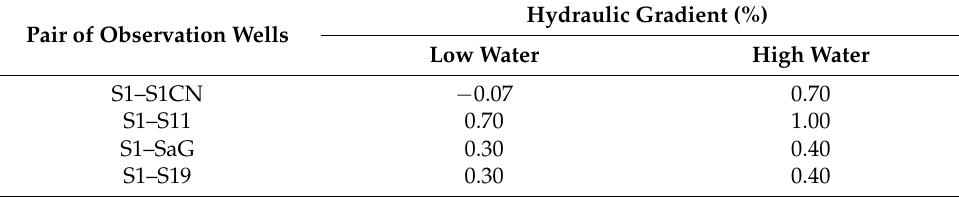
Table 1. Hydraulic gradients between the aquifers in the central valley where piezometer S1 is located and those at the end of the catchment area (north with S1CN, south with S11, east with SaG, and west with